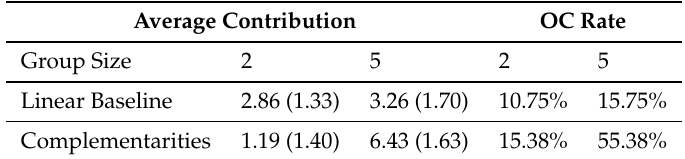
Table 8. Mean contribution and relative rate of over-contribution per